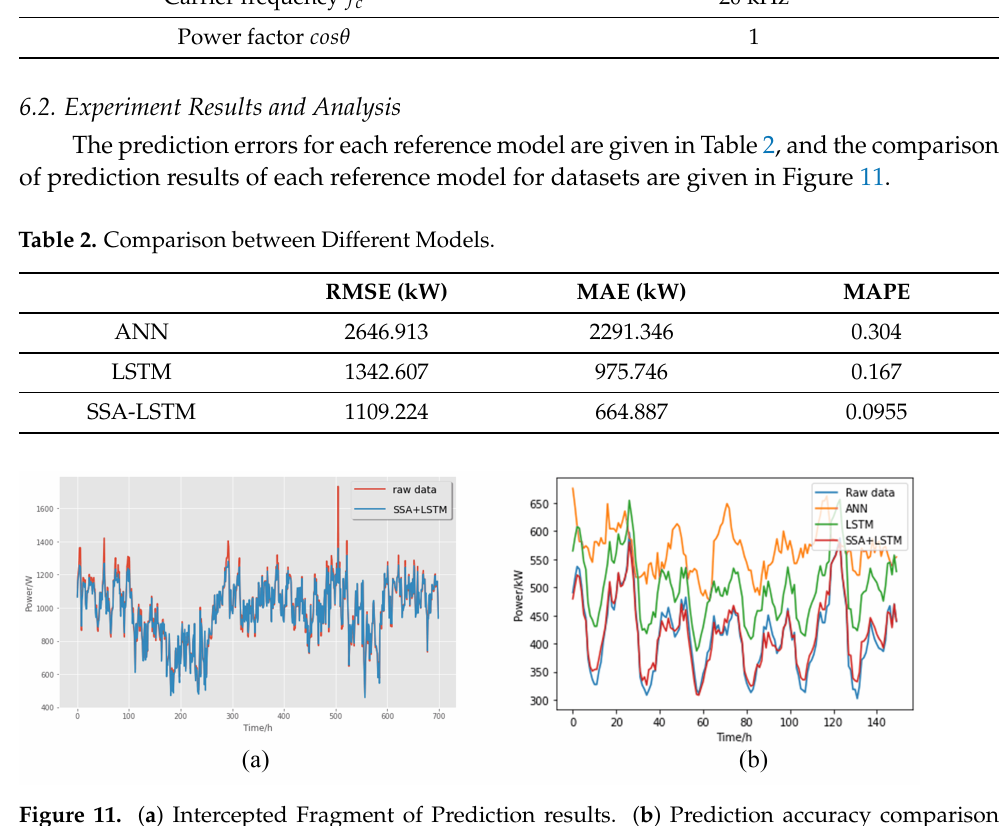
Figure 11. ( a ) Intercepted Fragment of Prediction results. ( b ) Prediction accuracy comparison between different